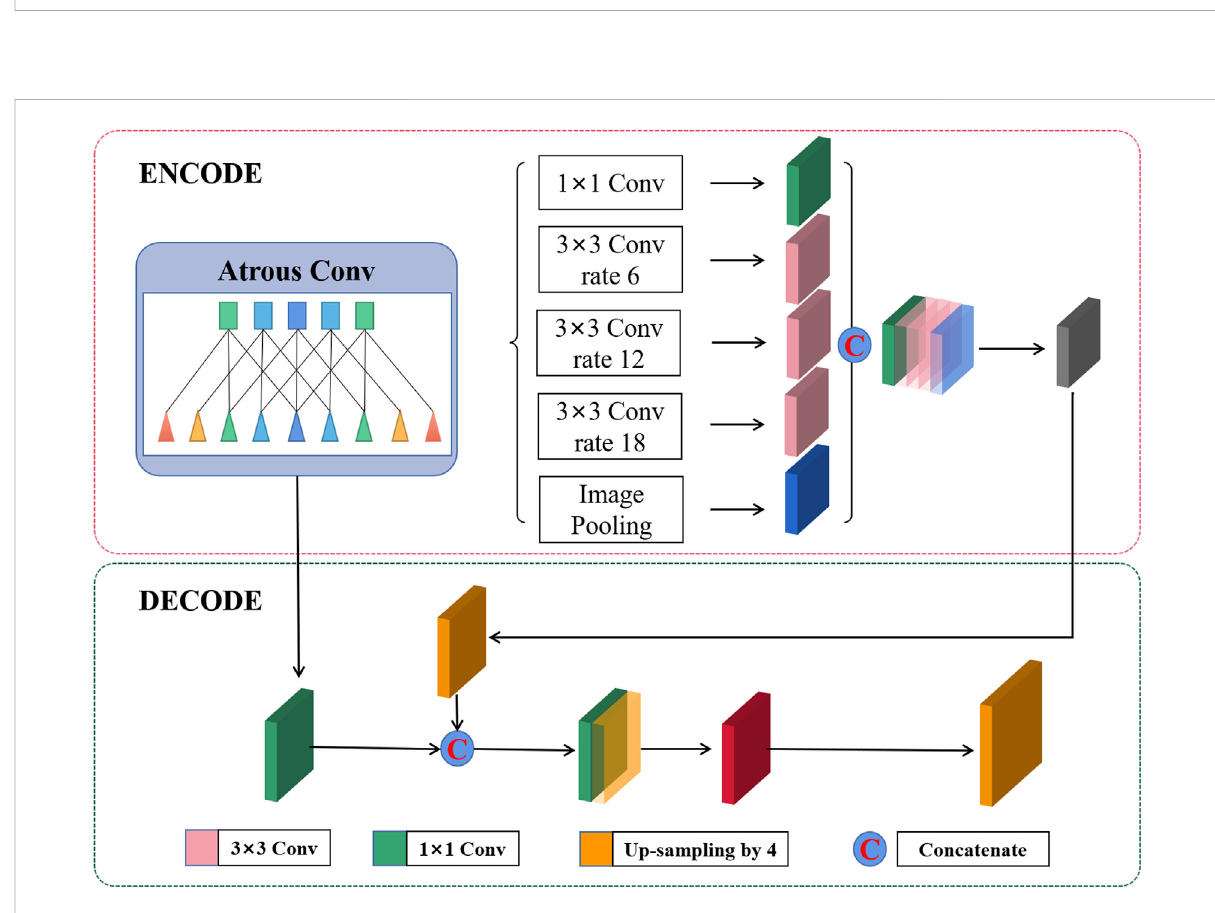
FIGURE 3 DeepLabv3+